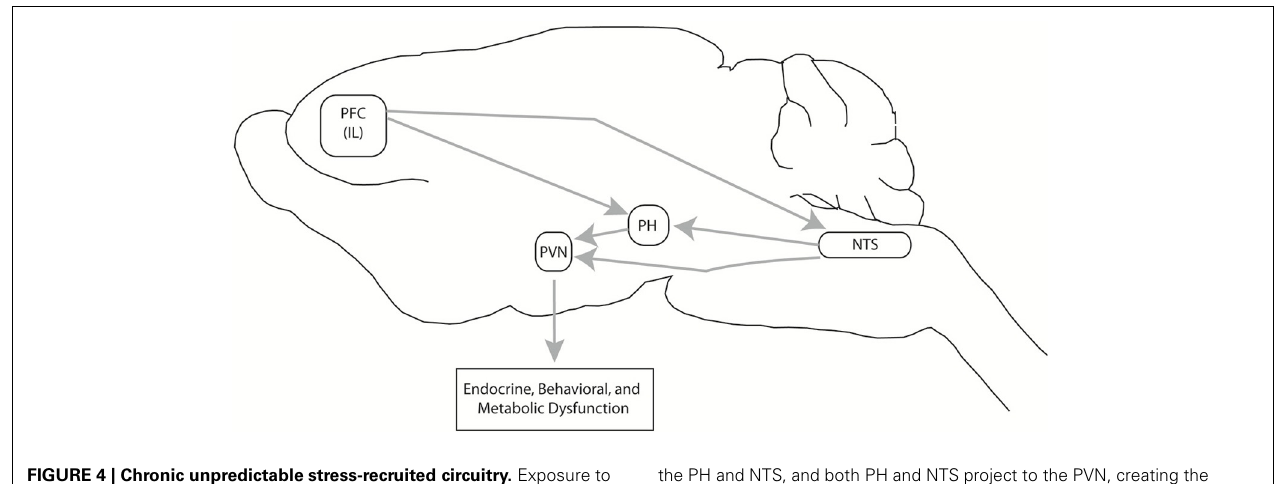
the PH and NTS, and both PH and NTS project to the PVN, creating the opportunity for PFC-PVN regulation in parallel, in series, or both. Via this pathway, chronic stress can increase drive to the PFC and subsequently cause glucocorticoid-mediated endocrine, behavioral, and metabolic dysfunction. This figure is reprinted from Flak et al. (2012), with